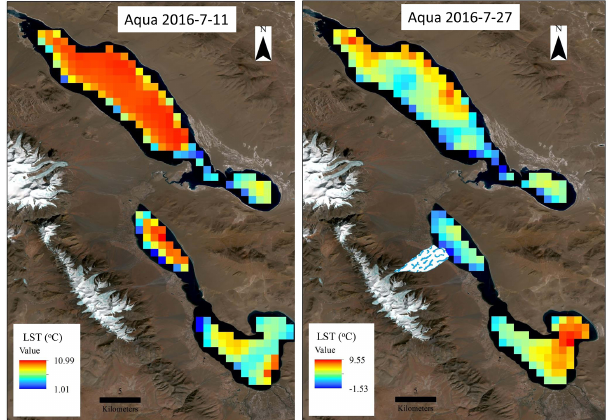
Figure 10. Spatial distribution of nighttime lake surface temper- ature at Aru Co and Memar Co before (11 July 2016) and after (27 July 2016) the Aru-1 glacier collapse. Landsat satellite image is used to indicate the location of the two lakes and the Aru-1 ice